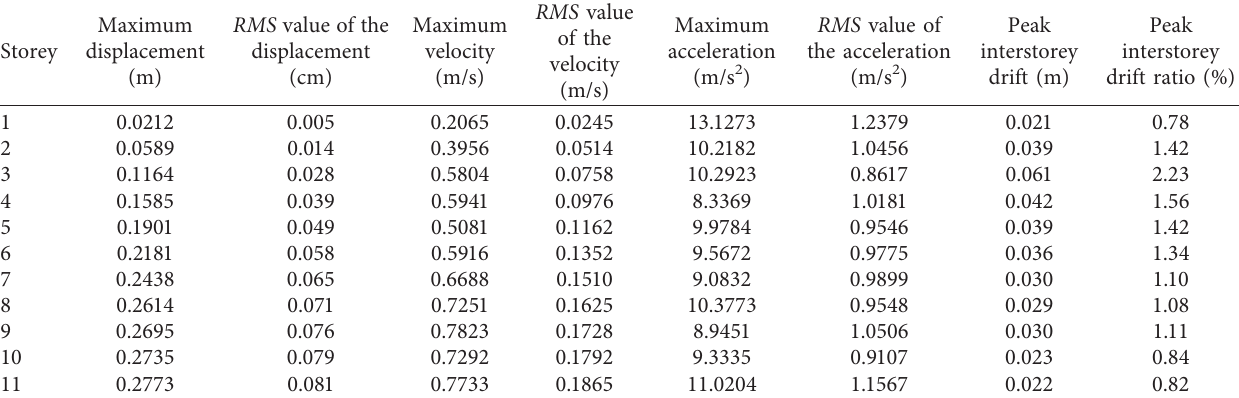
Table 4: Response of the uncontrolled structure when it is excited by “ Christchurch ” earthquake.